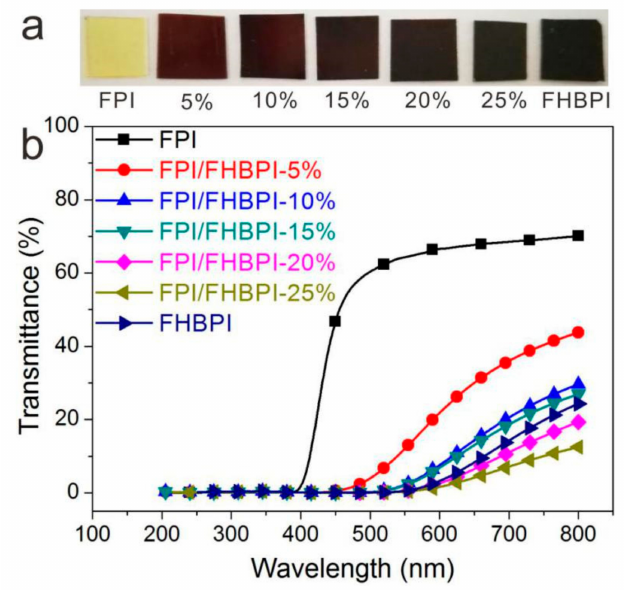
Figure 6. ( a ) Digital photographs and ( b ) UV-vis light transmittance spectra of FPI, FPI / FHBPI composites and FHBPI.